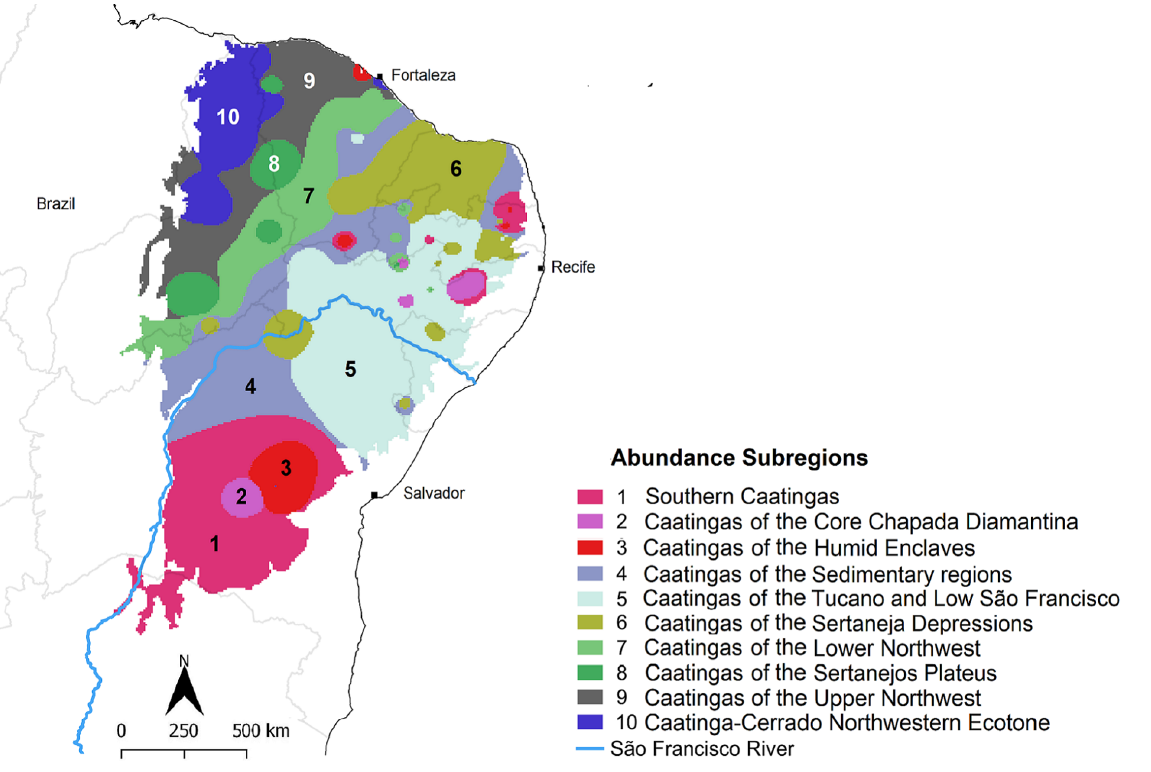
Figure 2. Tree compositional variation in the Seasonally Tropical Dry Forest of South America (STDF). The colours of the map have no absolute meaning, only the colour differences between locations are meaningful. Woody plant regionalization into 10 abundance subregions based on K-means partitioning of the interpolated NMDS